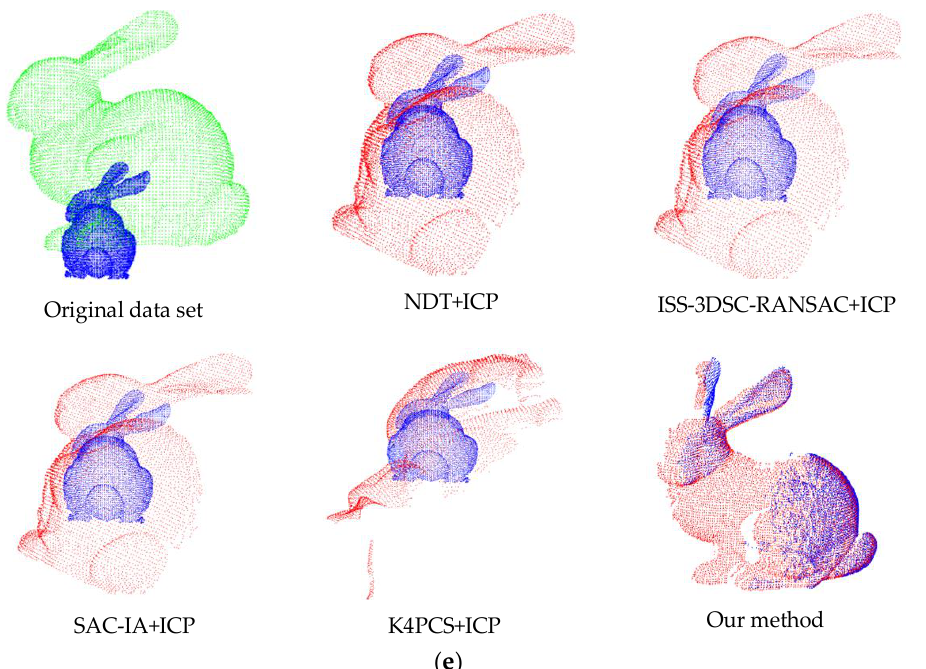
Figure 10. The visual registration results for testing data sets with five coarse-to-fine registration methods. ( a ) The original scanned face data and registration results of face000-face 045 with five coarse-to-fine registration methods. ( b ) The original room data and registration results of room000- room040 with five coarse-to-fine registration methods. ( c ) The original bunny rabbit data and registration results of bun045-bun090 with five coarse-to-fine registration methods. ( d ) The original scaled dragon data and registration result of dragon000-dragon048 magnified 2 times with five coarse-to-fine registration methods. ( e ) The original scaled bunny rabbit data and registration results of bun045-bun090 magnified 0.5 times with five coarse-to-fine registration methods.